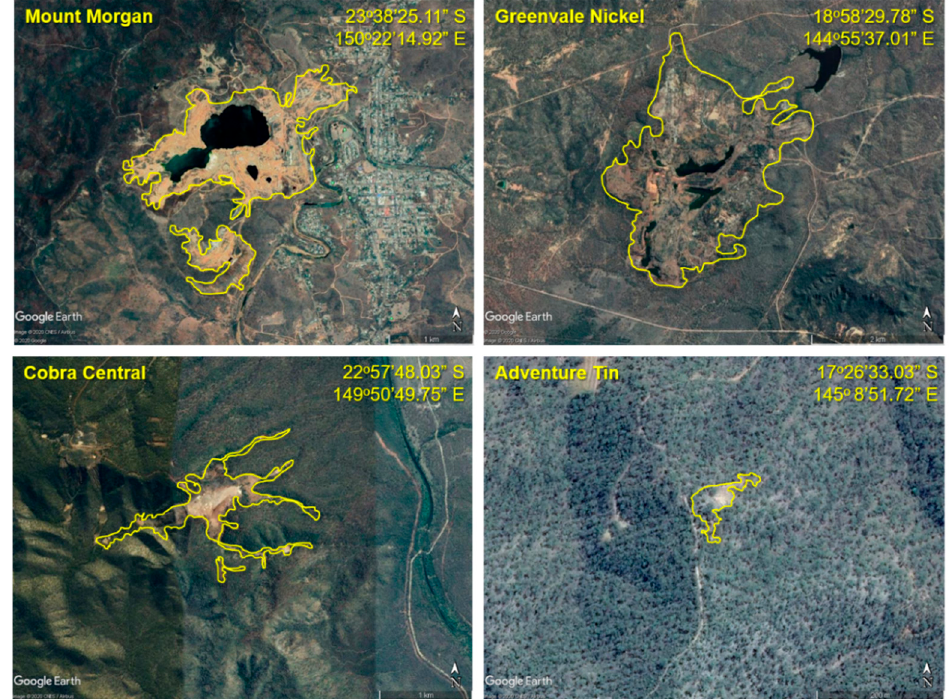
Figure 2. Selected mine sites in the state of Queensland for environmental risk analysis. Imagery derived from the most recent cloud-free composites available in Google Earth Pro. Areas in yellow were delineated by visual inspection per Werner et al. [11] .